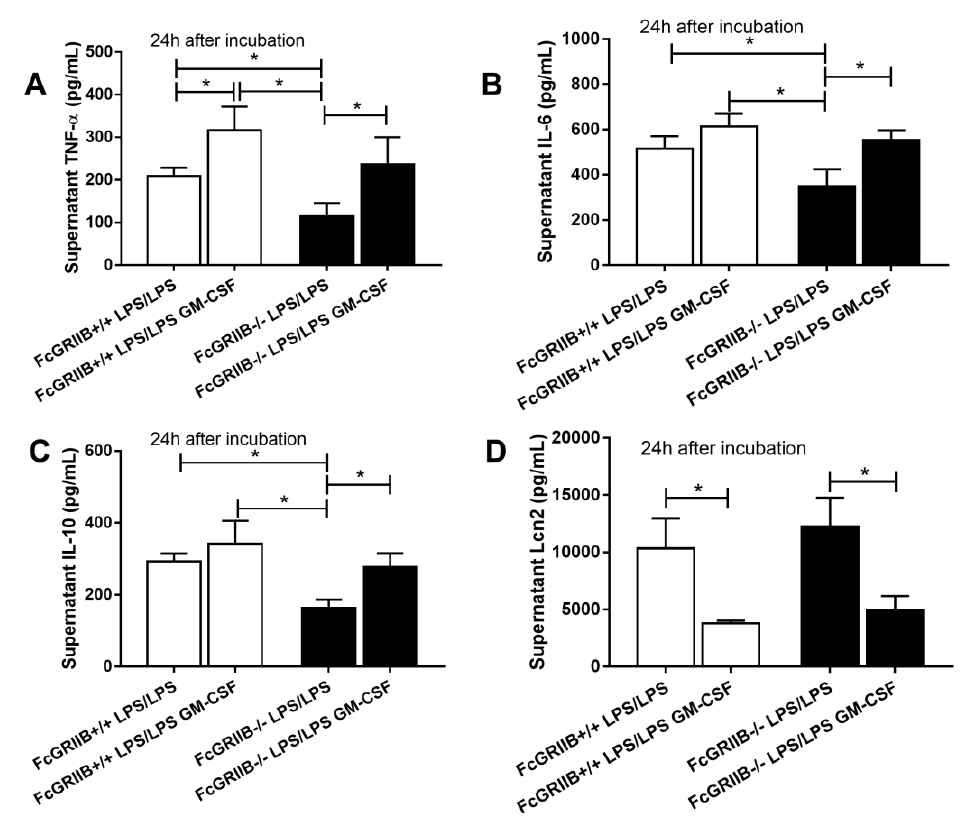
Figure 7. The impact of granulocyte-monocyte colony stimulating factor (GM-CSF) against LPS tolerance (double LPS stimulation; LPS/LPS) in wild-type (WT) and FcGRIIb-/- macrophage as determined by supernatant cytokines ( A – C ) and Lipocalin-2 (Lcn-2) ( D ) were demonstrated. (Independent triplicate experiments were performed for all experiments; *, p < 0.05; *, p < 0.01).